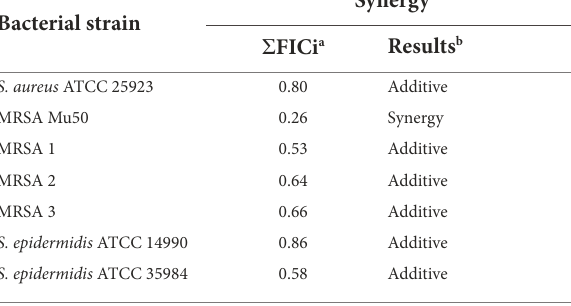
TABLE 3 Synergistic effects of diethyldithiocarbamate in combination with Cu 2+ against S. aureus, MRSA and S. epidermidis biofilms.